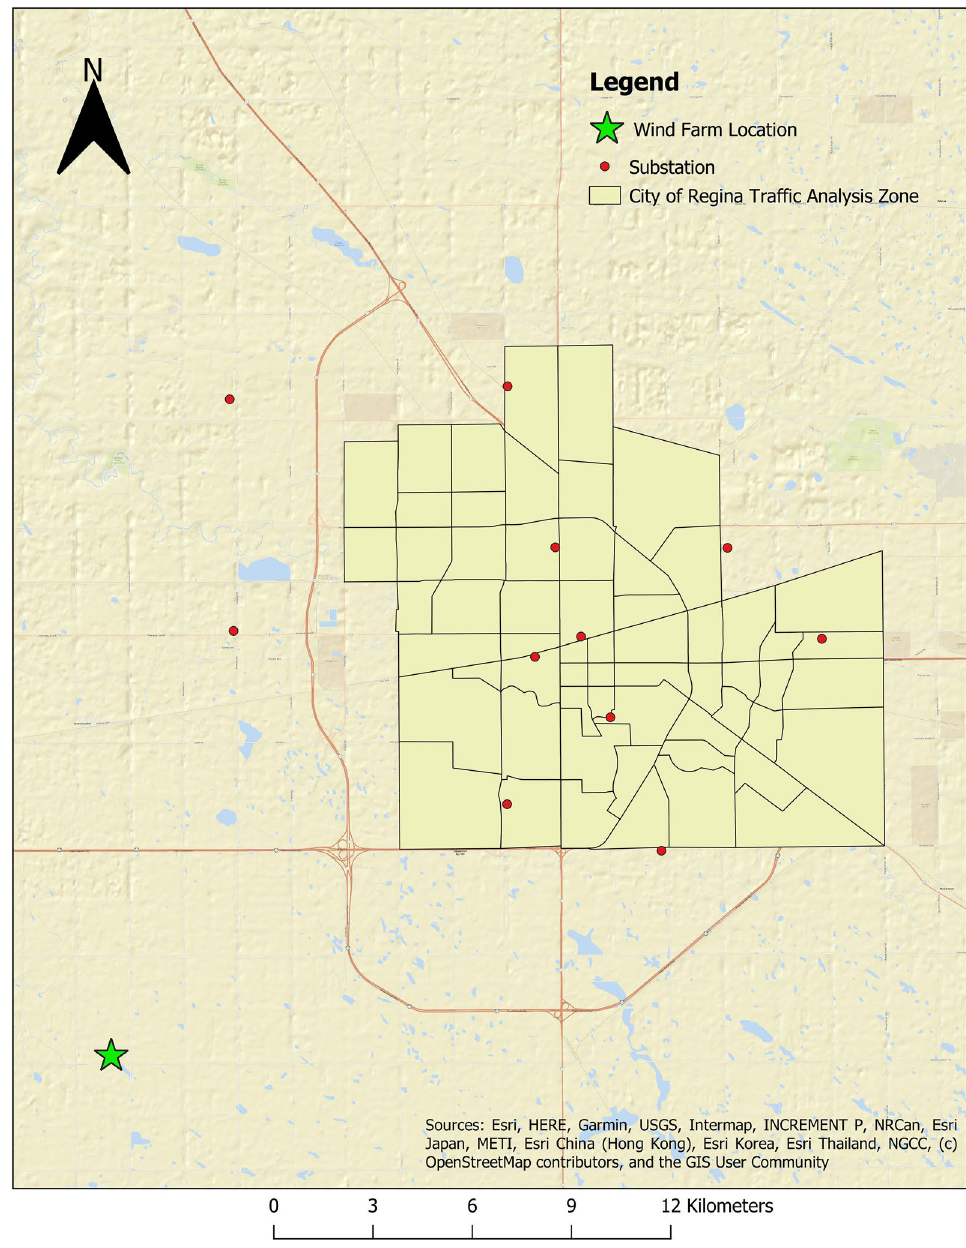
Fig. 4 Extent of study area, substation locations used in SILVER, and location of wind